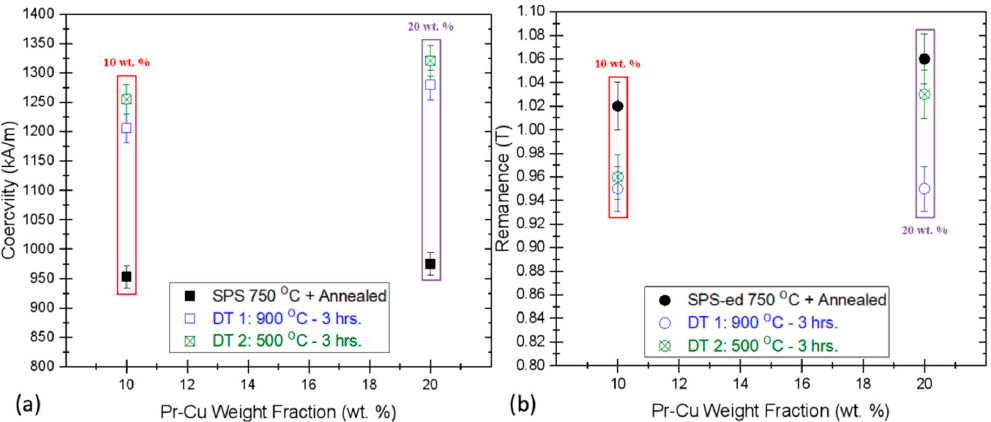
for di ff erent wt. % Pr 68 Cu 32 alloy ribbons. Plots legend: red 10 wt. % and purple 20 wt. % Pr-Cu as the di ff usion source on fresh HDDR Nd-Fe-B SPS-ed magnets Figure 3C–F confirms gradient microstructure of the Pr-Cu GBDP HDD Nd-Fe-B magnet with